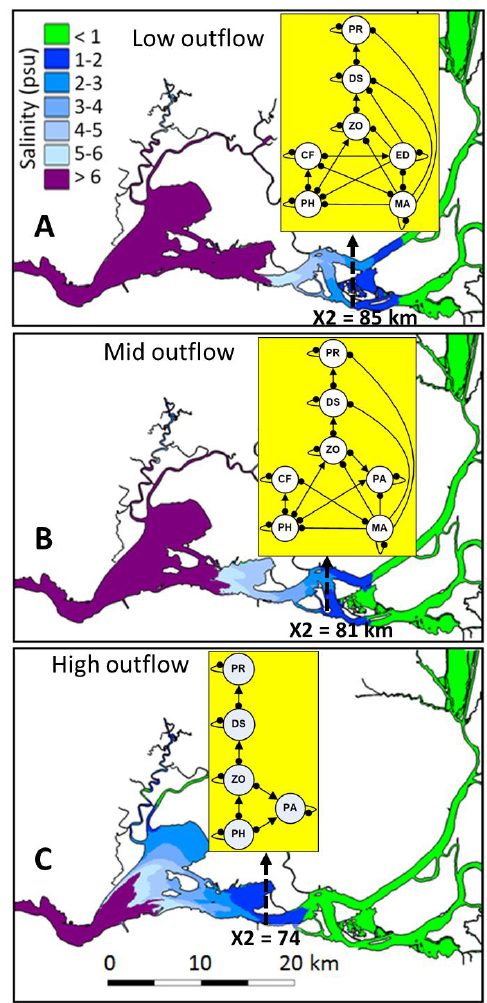
Figure 3. Alternative fall community models for the Delta smelt subsystem under three scenarios of the salinity field in upper San Francisco Estuary. Dashed arrows show where the low salinity zone overlaps the position of the 2 psu isohaline (X2) at ( A ) high X2 (85 km), ( B ) mid X2 (81 km), and ( C ) low X2 (74 km) at low-, mid- and high-outflow, respectively. Community variables included in signed digraphs: CF = Corbicula fluminea ; DS = Delta smelt; ED = Egeria densa ; MA = Microcystis aeruginosa ; PA = Potamocorbula amurensis ; PH = phytoplankton; PR = predators of delta smelt; ZO = zooplankton. Salinity field after [75].